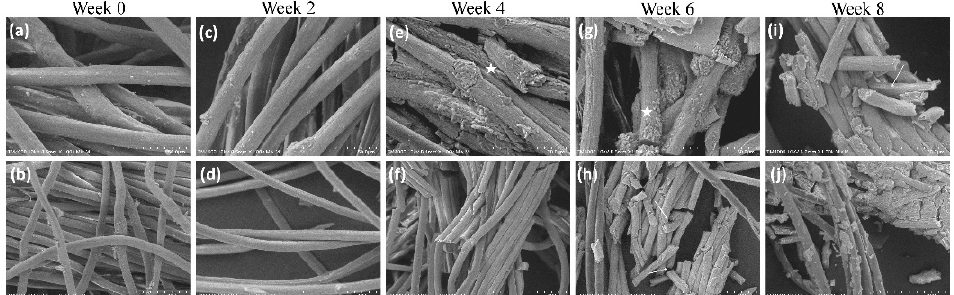
Figure 4. Bulk and surface degradation is observed over 8 weeks. The samples were subjected to collagenase for 8 weeks. The morphology of the fibers was observed via SEM. The fibers had broken down and degraded significantly at week 8 (images i , j ) when compared to week 0 (images a , b ). The surface of the fibers also changed, which shows that there is surface degradation in the fibers ( n = 6). The top images ( a , c , e , g , i ) show a higher magnification (50 um), whereas the bottom images ( b , d , f , h , j ) show a lower magnification (100 um). Arrows indicate broken fiber lengths; stars indicate a surface transition from smooth to rough and